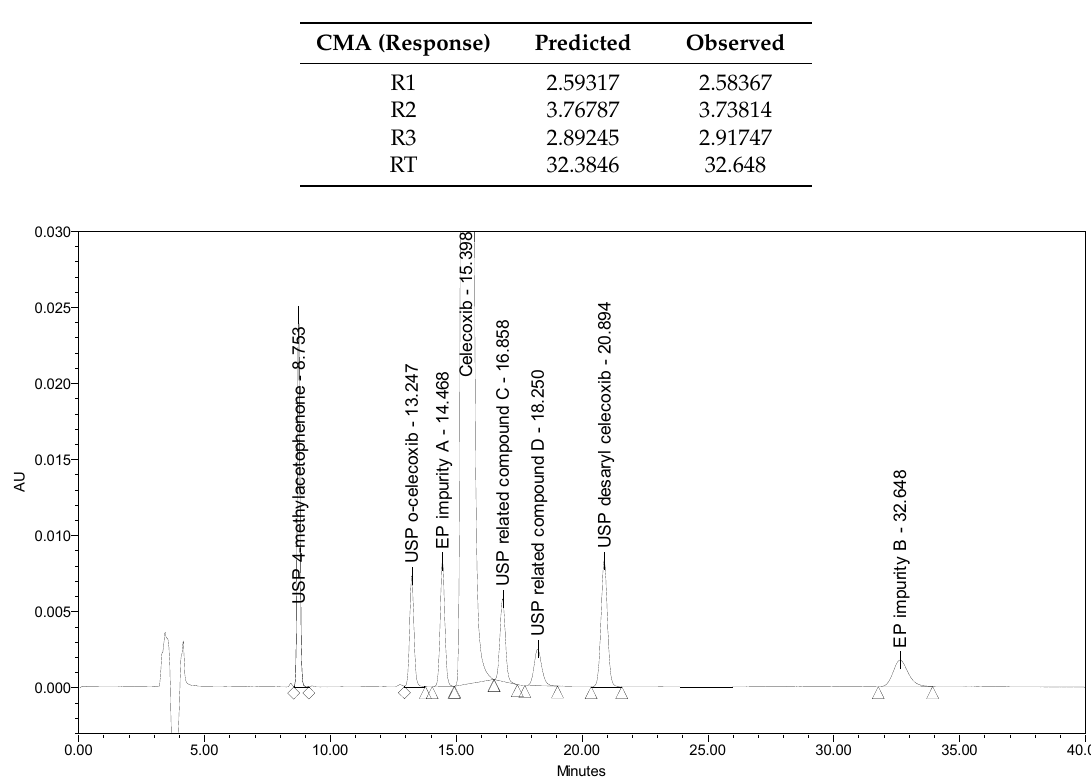
Table 3. Statistical model prediction for CMAs at optimal conditions of CMPs and experimentally obtained results.